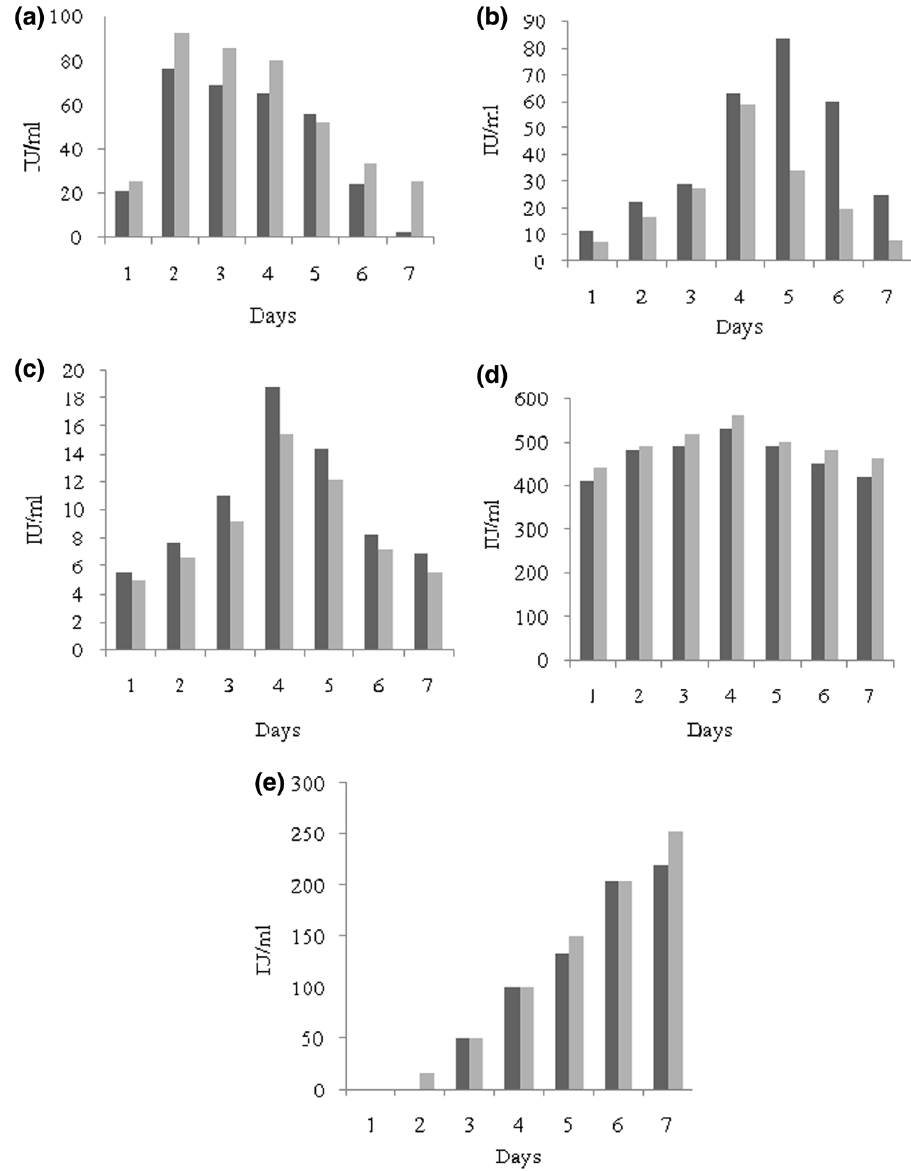
Fig. 2 Concomitant enzyme production by consortium 1 (black bar) and consortium 2 (grey bar) amylase activity ( a ), cellulase activity ( b ), protease activity ( c ), pectinase activity ( d ) and lipase activity (